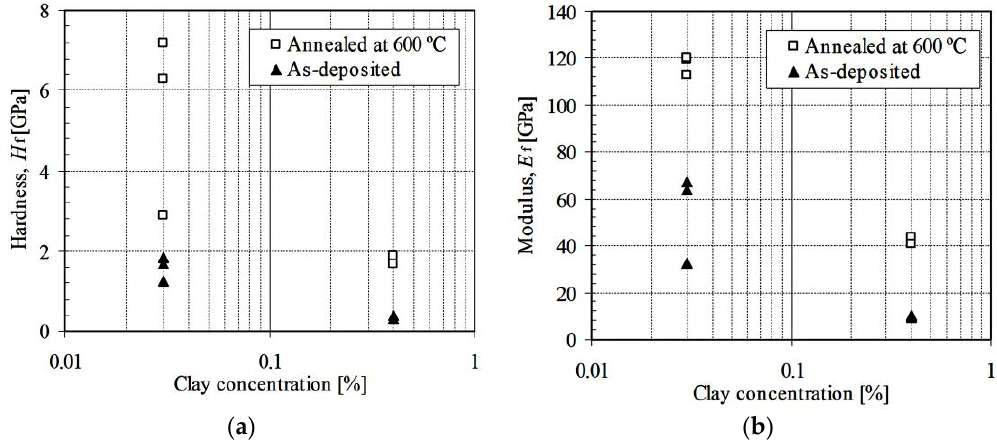
Figure 9. Effect of clay suspension concentration on hardness ( a ) and modulus ( b ) of zirconia-clay multilayers under as-deposited and annealed at 600 °C conditions.